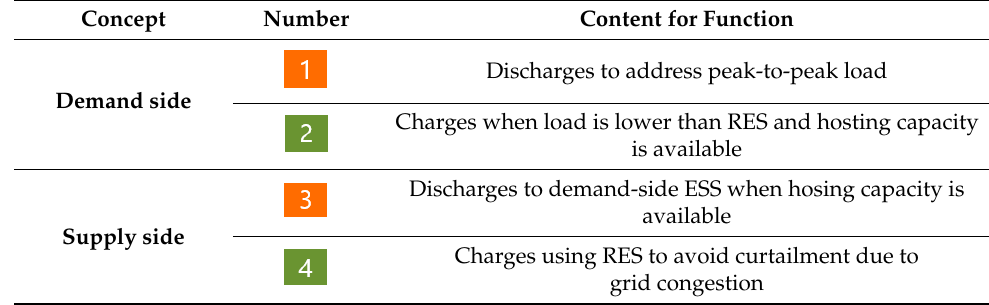
Figure 1. Concept for VPL operation method by ESS. Table 1. Classification for two functions of VPL.